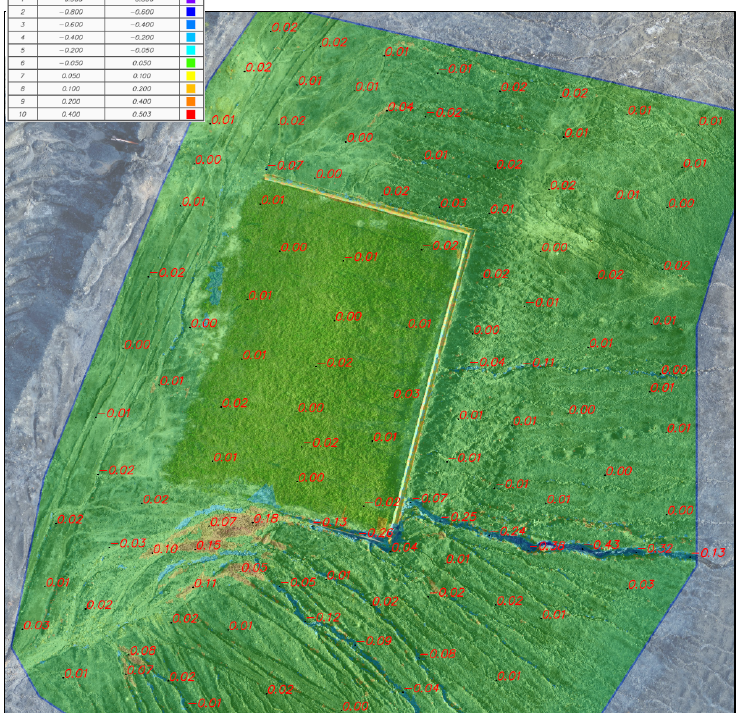
Figure 15. Map of size of increases (+) and decreases (−) on the mine waste dump slope (m).